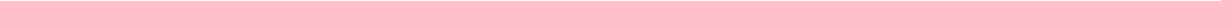
Fig. 4 The WHHERE complex is recruited to the promoter of retinoic acid target genes. a RARE-Luciferase activity, b qPCR analysis of Rar β expression of NIH3T3 treated with 1 µ M RA ( blue ) or 1 µ M RA and 100 nM TSA ( green ) ( n = 4 each). c , d Rar β -promoter ChIP analysis from E8.75 RARE-LacZ mouse embryos with antibodies against Rar α c or Rere, Wdr5, Hdac1, and Hdac2 d . Top panels c , d : RARE element of the Rar β promoter ChIP ( n = 3). Bottom panels : control ChIP from Rar β promoter upstream region ( − 3 Kb). e , f ChIP analysis of the RARE sequence in the RARE-LacZ reporter with antibodies against Rar α e or Rere, Wdr5, Hdac1, and Hdac2 f using E8.75 RARE-LacZ mouse embryos ( n = 3). g – i ChIP analysis of Rar β promoter in NIH3T3 treated or not during 1 h with 1 µ M RA using antibodies for Rar α g , Rere, Wdr5, Hdac1, and Hdac2 h , Pol II i . Top panels h , i : ChIP of the RARE element in the Rar β -promoter ( n = 3). Bottom panels : control ChIP from Rar β -promoter -upstream region ( − 3 Kb). j ChIP of the Rar β promoter with Pol II antibody using NIH3T3 cells treated with 1 µ M RA or 1 µ M RA and 100 nM TSA for 1 h ( n = 3). k ChIP with Pol II antibody from NIH3T3 transfected with siRNA for Hdac1 and treated with 1 µ M RA during 1 h ( n = 3). l – n Co-immunoprecipitation using NIH3T3 transfected with Flag-Hdac1 l , Rere-HA and Flag-Hdac1 m , n , with anti-Flag l , m or anti-HA n antibody and immunoblots (IB) for Flag-Hdac1, Rere-HA, and Rar α . o Rar β -promoter ChIP analysis from E8.75 RARE-LacZ mouse embryos with an anti-Ehmt2. Top panel o : RARE element ChIP of the Rar β promoter ( n = 3). Bottom panel : control ChIP from Rar β promoter upstream region ( − 3 Kb). p ChIP analysis of the RARE sequence in the RARE-LacZ reporter with an anti- Ehmt2 using E8.75 RARE-LacZ mouse embryos ( n = 3). Data represent mean ± s.e.m. unless otherwise speci fi ed. NS — not signi fi cant, * P < 0.05 and ** P < 0.01. Student ’ s unpaired two-tailed t